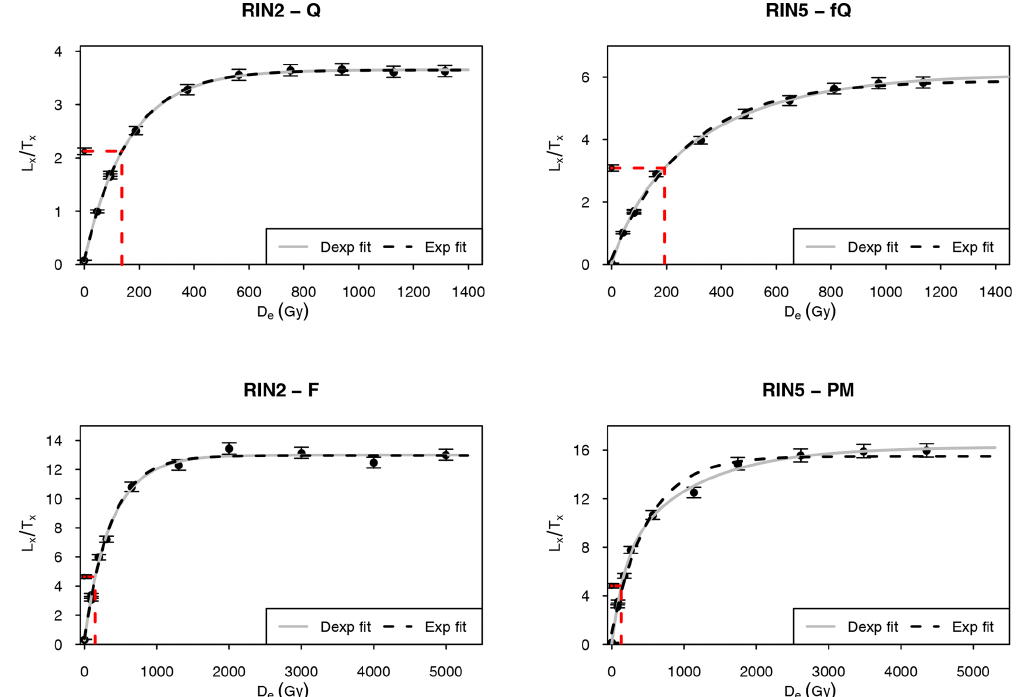
Figure 9. Extended dose response curves for RIN2 Q and F and RIN5 f Q and